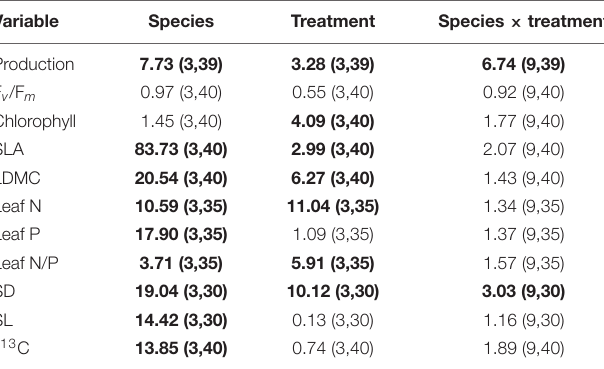
TABLE 3 | Results from univariate factorial analyses of variance (ANOVAs; F- values and associated d.o.f. for numerator and denominator in parenthesis) used to assess the effects of species identity, treatment and their interaction on production and foliar